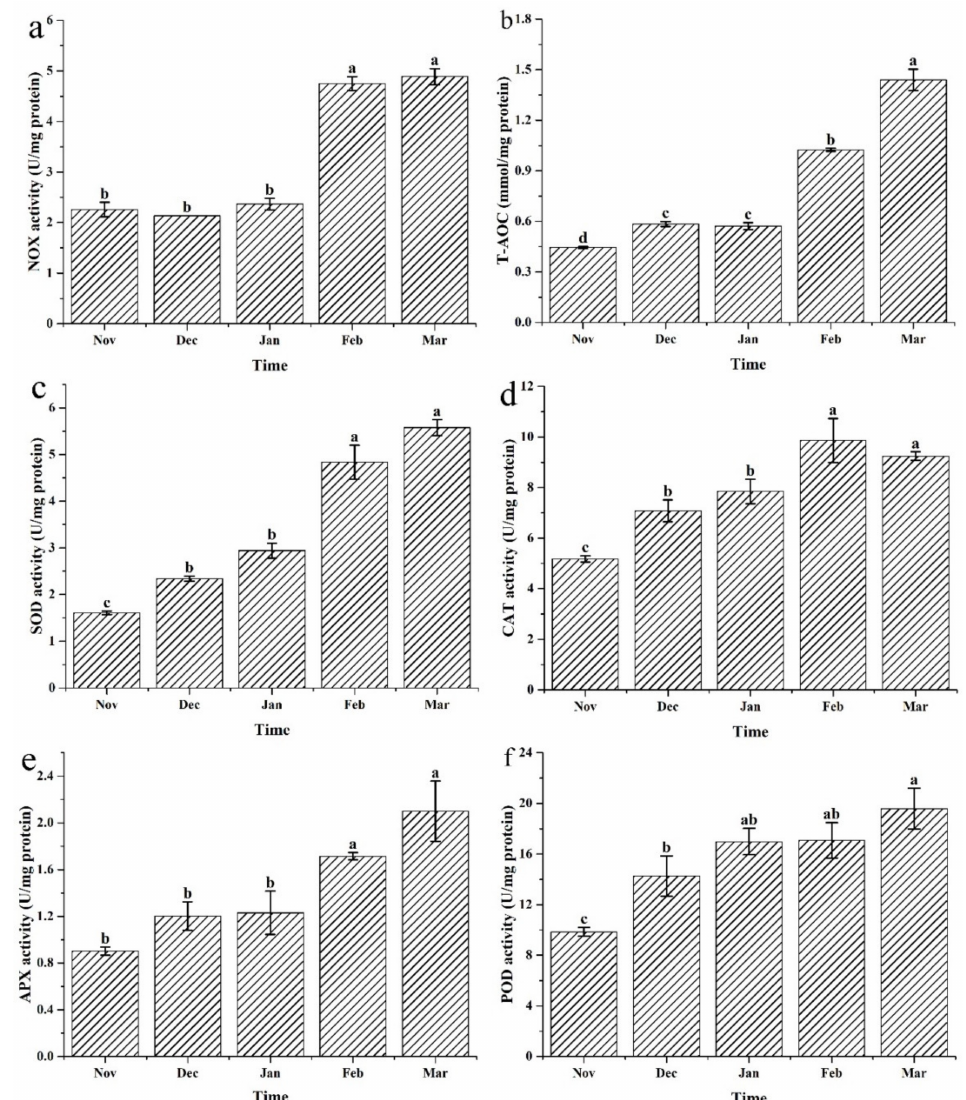
Figure 5. Changes of certain antioxidant enzymes in N. yezoensis collected from different cultivation periods. ( a ) NADH oxidase (NOX); ( b ) Total antioxidant capacity (T-AOC); ( c ) Superoxide dismu- tase (SOD); ( d ) Catalase (CAT); ( e ) Ascorbate peroxidase (APX); ( f ) Peroxidases (POD). Data were Mean ± SD ( n = 3). Different letters indicated significant differences ( p <